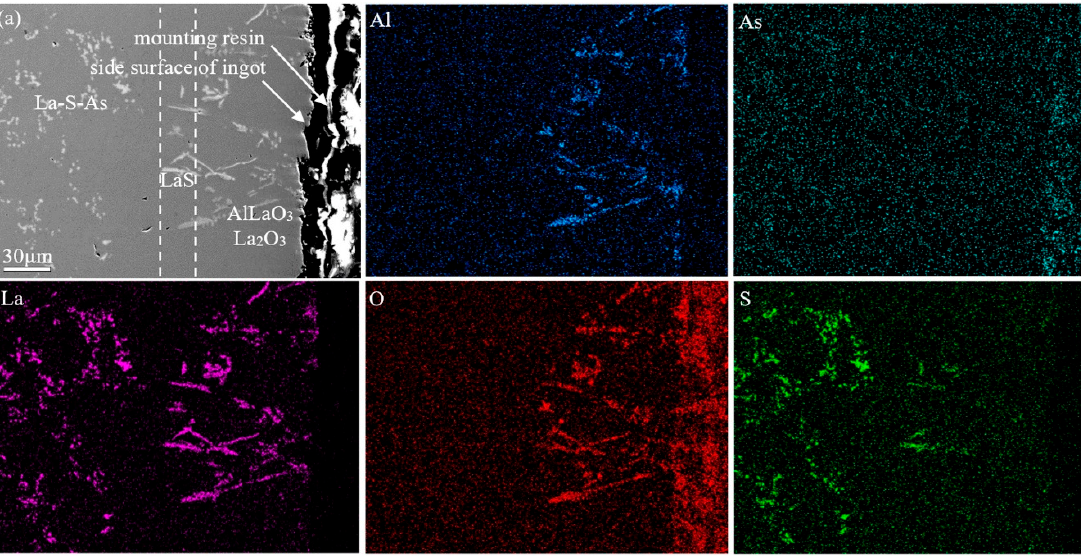
Figure 8. Morphologies and element distribution on the profile of the side surface of the ingot. ( a ) Backscattered electron image of morphologies .